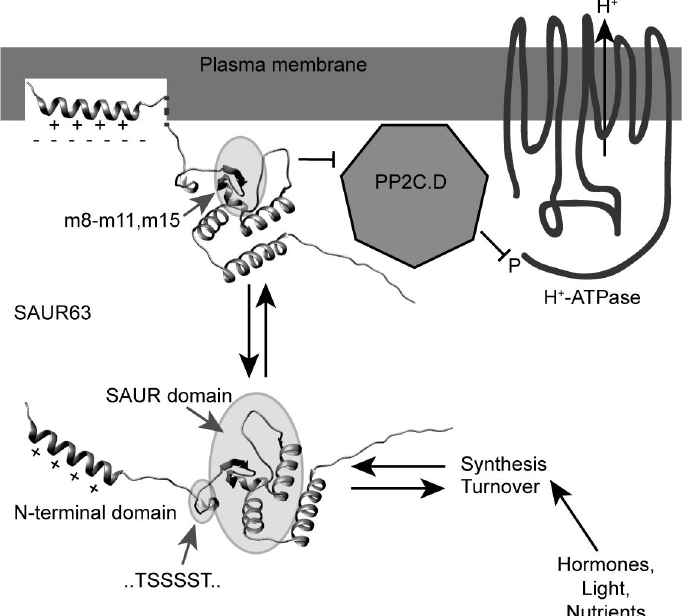
Fig 9. Model for SAUR63 dynamics. At lower center is a computationally predicted structure for SAUR63 with the N- terminal domain indicated and the SAUR domain surrounded by a shaded oval. The protein likely partitions dynamically between the cytosol (lower image) and PM association (upper image). The predicted basic amphipathic α - helix at the N-terminus (+ signs indicate positively charged face) can interact with the PM through electrostatic attraction to anionic phospholipids (- signs), and likely embedding of the hydrophobic face within the lipid bilayer. In addition, the conserved SAUR domain may interact with the PM through its association with PP2C.D or other PM- associated proteins. In the upper diagram, the shaded oval indicates the locations of amino acids corresponding to NAAIRS mutations m8 - m11 and m15 in the predicted structure, which include sequences that affect both PM localization and growth-promoting activity. Orientations of the N-terminal and SAUR domains were adjusted independently in the upper diagram to illustrate these putative interactions with the PM. The linker between the N- terminal domain α -helix and the SAUR domain may be flexible enough to allow these orientations. This linker also has a stretch of six consecutive phosphorylatable amino acids (TSSSST, location indicated by small shaded oval in the lower diagram). Inhibition of PP2C.D proteins by SAUR63 would prevent dephosphorylation of the PM H + -ATPase, thereby maintaining its activity for acid growth (26). Rapid partitioning between PM-associated and soluble pools, as well as fast synthesis and turnover of SAUR63 and other SAURs, would allow sensitive regulation of activity by changes in signaling by hormones, light, or nutrients. The computational model of SAUR63 structure was taken from the Alphafold 2.0 website [[39,81], https://alphafold.ebi.ac.uk/entry/F4I1H5] and visualized and oriented using Chimera software [82],